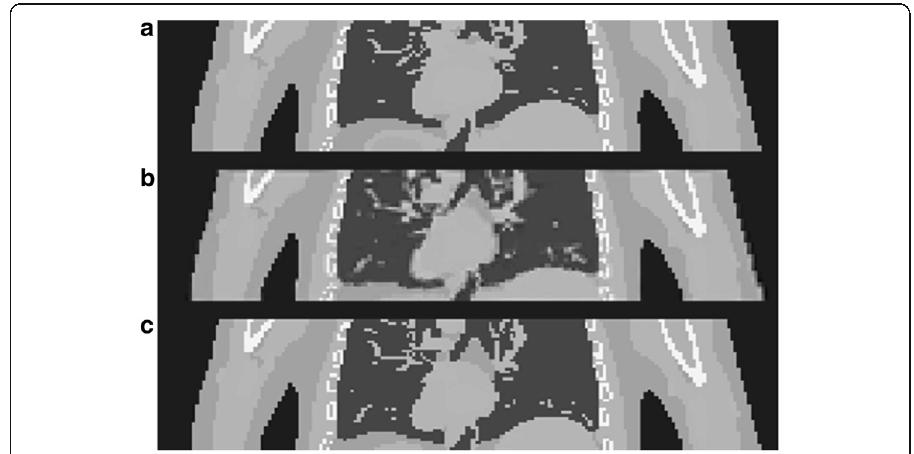
Fig. 5 Motion phase-dependent PET attenuation maps. The attenuation map in the reference motion phase was transformed to end-inspiration/end-systole using the estimated motion fields. The resulting attenuation map is similar to the true attenuation map for end-inspiration/end-systole obtained directly from XCAT. a Reference motion phase (end-diastole/end-exhalation) b Transformed from the reference phase to end-inspiration/end-systole c End-inspiration/end-systole (directlyu form